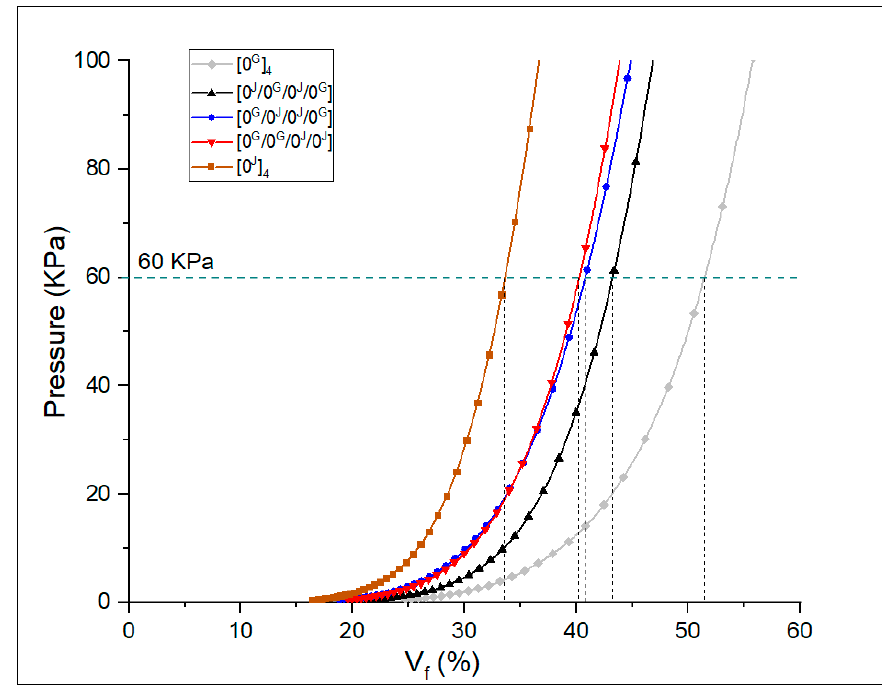
Figure 3. Pressure vs. predicted fibre volume fraction of the fabric preforms.